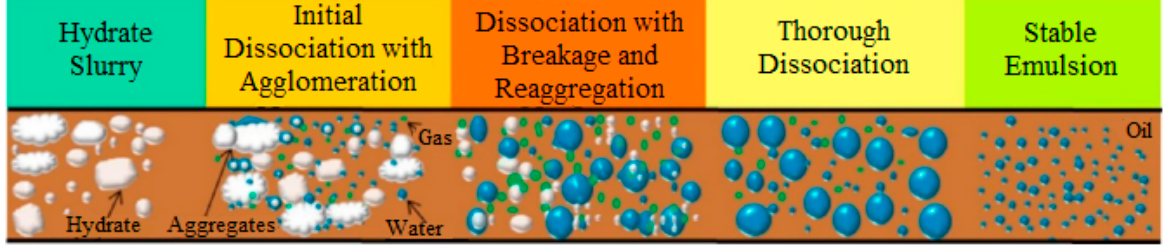
Figure 4. Conceptual model of the hydrate decomposition process in an oil-dominated flow system. Reproduced with permission from Ref [37] Copyright 2018 Elsevier.